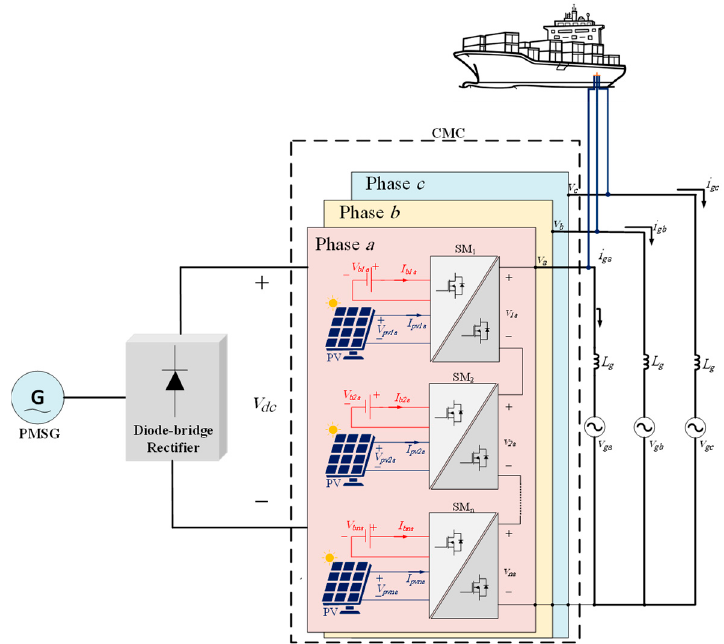
Figure 6. The proposed connection of the CMC.